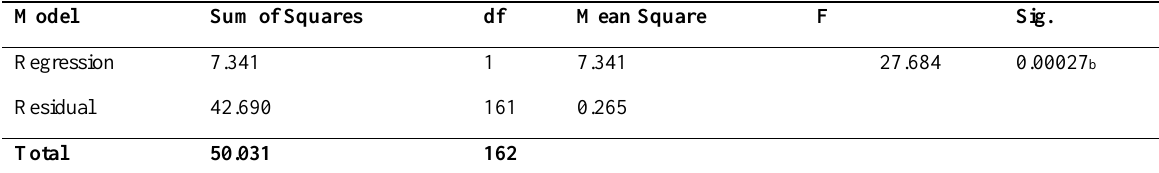
Table 7: Test for model fitness for predicting support service linkage and sustainability of DFLPs